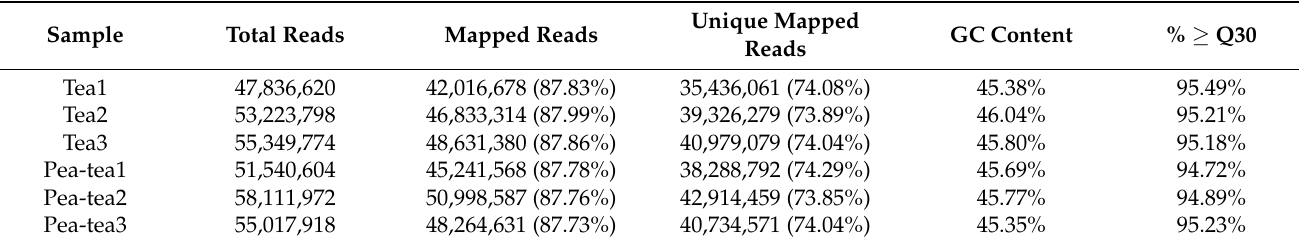
Table 1. Quality of transcriptomic data.